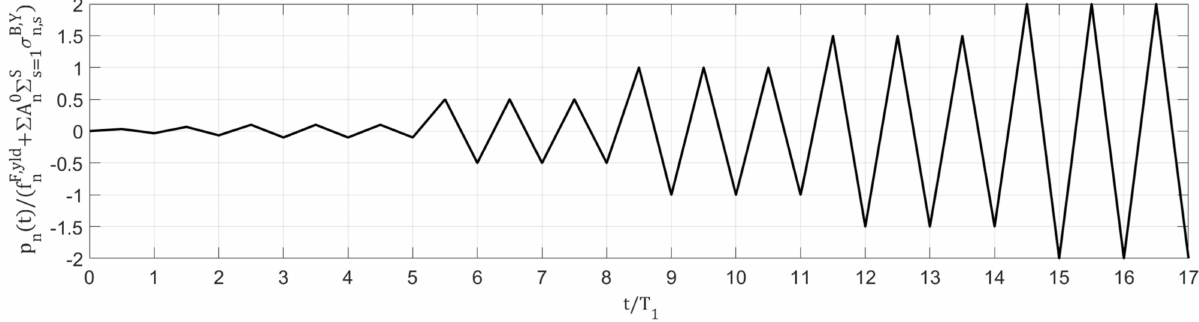
Figure 2. Quasi-static cyclic